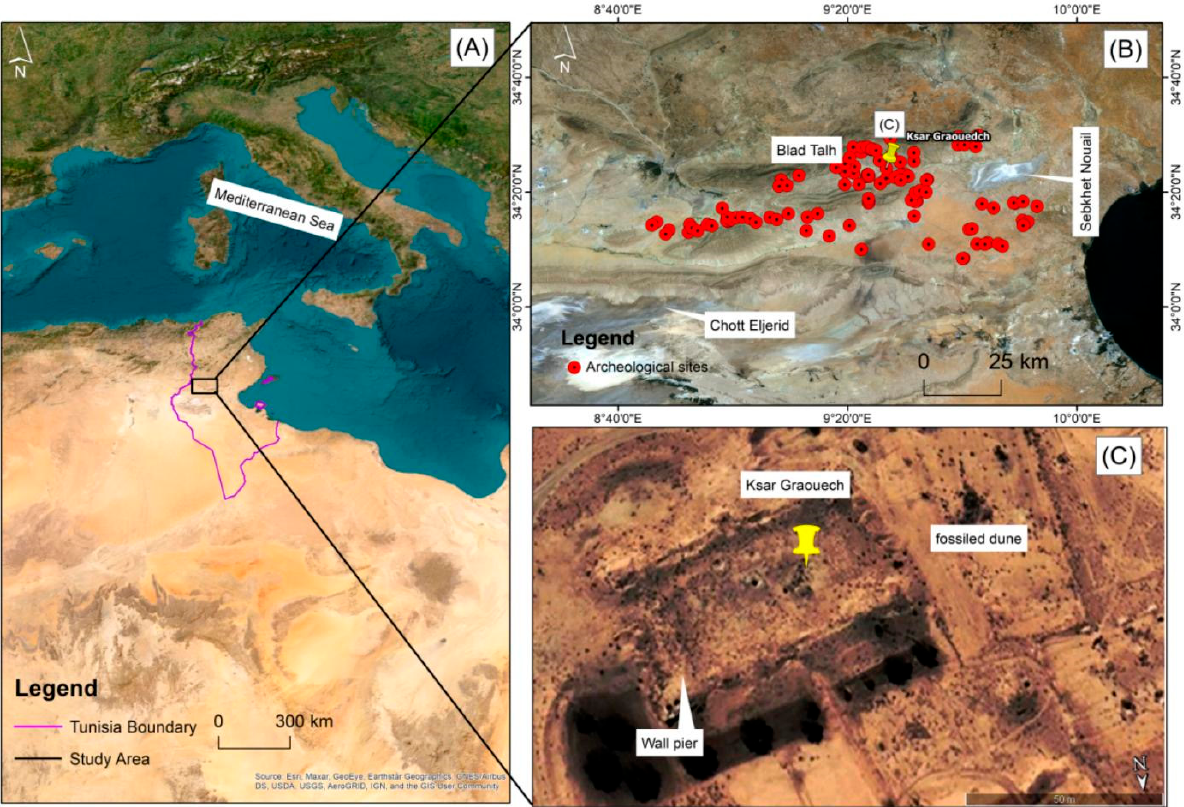
Figure 1. ( A ) Study area location in Tunisia (North Africa); ( B ) Archaeological sites in the Roman Fort area; ( C ) Fort of KSAR GRAOUECH surrounding wall and Fort area; ( C ) Fort of KSAR GRAOUECH surrounding wall and remains.